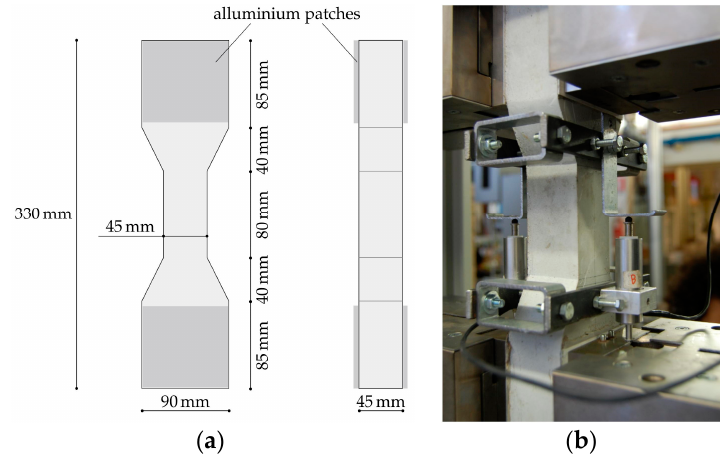
Figure 2. ( a ) Dog-bone specimen geometry; ( b ) experimental set-up of a tensile